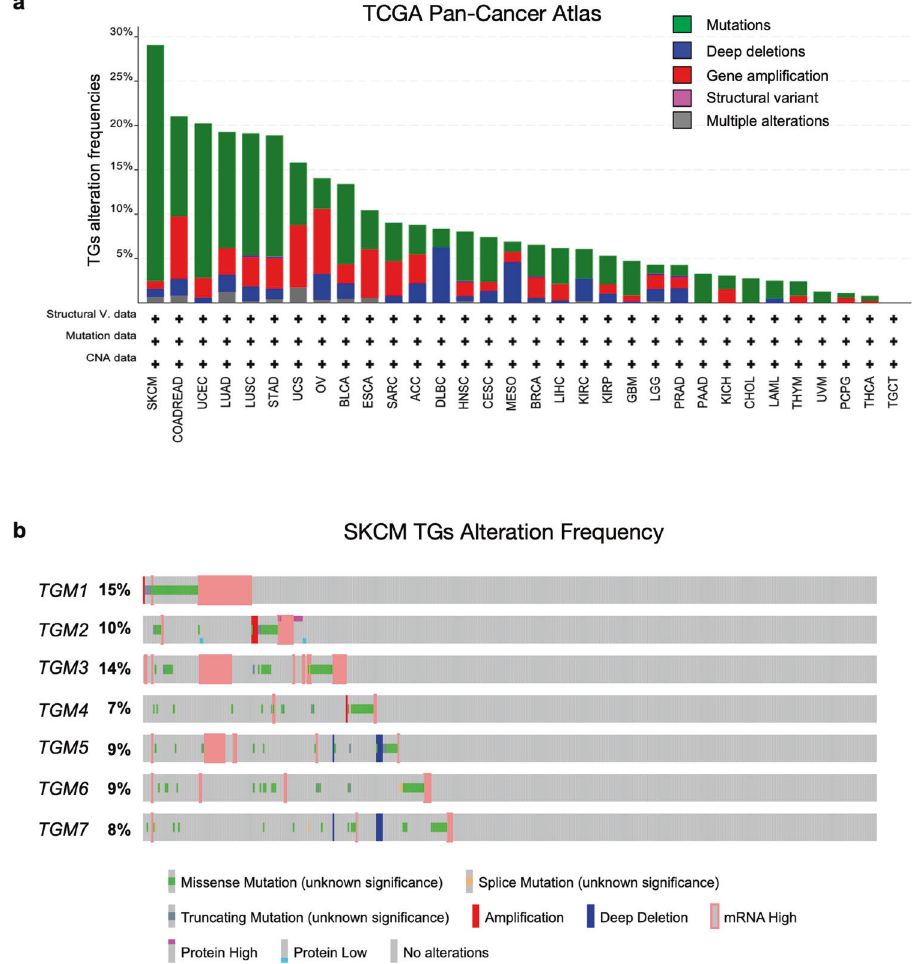
Fig. 1 Genomic alteration frequency data of the TGs family in human cancers. a Mutation frequencies of TGs in 32 cancer studies were retrieved from cBioPortal (TCGA Pan-Cancer Atlas dataset). b Alteration frequencies representation of each TGs member in SKCM dataset were obtained from cBioPortal (TCGA Pan-Cancer Atlas